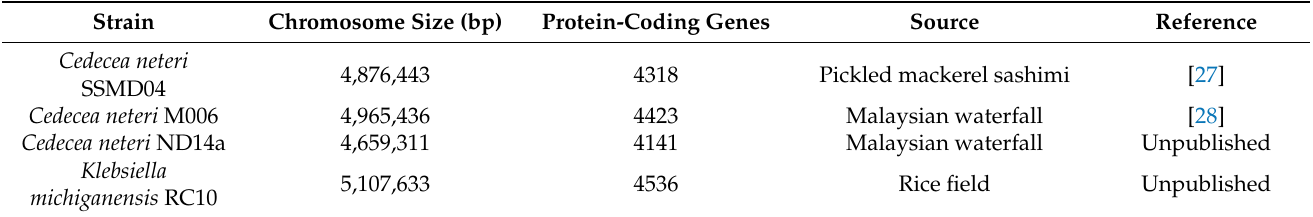
Table 1. Completely sequenced genomes of bacterial strains analyzed in this